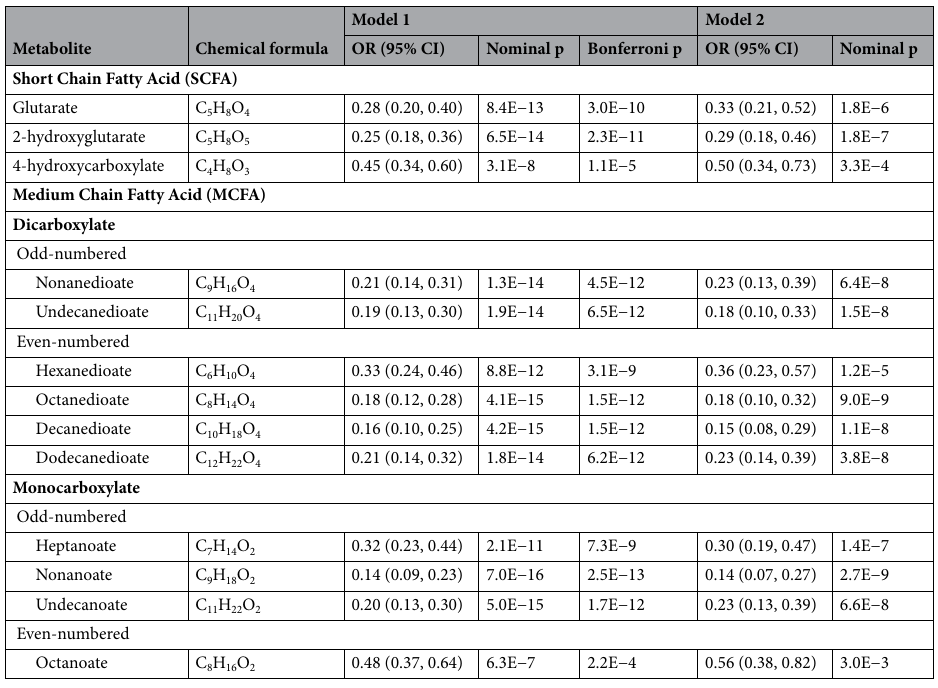
Table 2. Short and Medium Chain Fatty Acids associations with recent, persistent normoalbuminuria in subjects with a long duration of T1D and normal renal function. Logistic regression analyses are adjusted for clinical covariates. Model 1 is corrected for age, gender, HbA 1c , and eGFR. Model 2 is additionally corrected for systolic blood pressure, diastolic blood pressure, cholesterol, HDL, ACE inhibitor/ARB use, other antihypertensive treatment, and statin use. Effect sizes are shown per one quartile change. Protective Short and Medium Chain Fatty Acids are ordered by structural features and subsequently by the number of carbons. OR odds ratio, CI confidence intervals. For more comprehensive logistic analyses of all Fatty Acids, please refer to Supplementary Table S1.